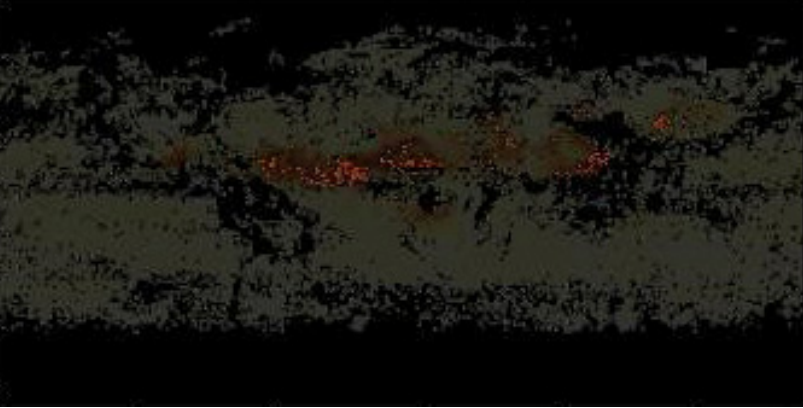
Figure 5. Predicted image on/for the eighth day with spots showing the highest AOT on a global map.